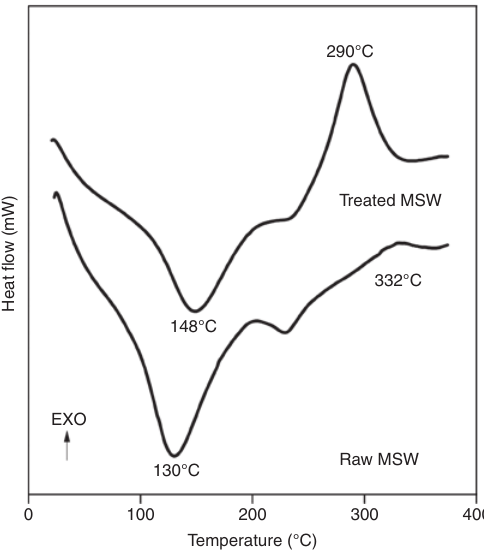
Figure 7 DSC thermograms of raw and MSW.